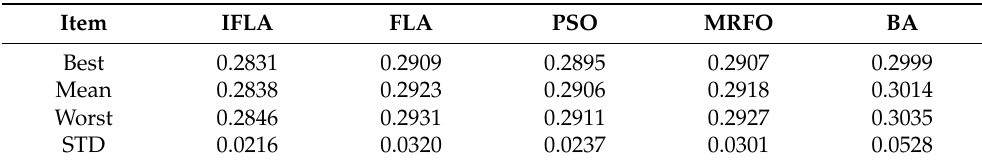
Table 8. The performance comparison of different algorithms using the statistic analysis with storage degradation